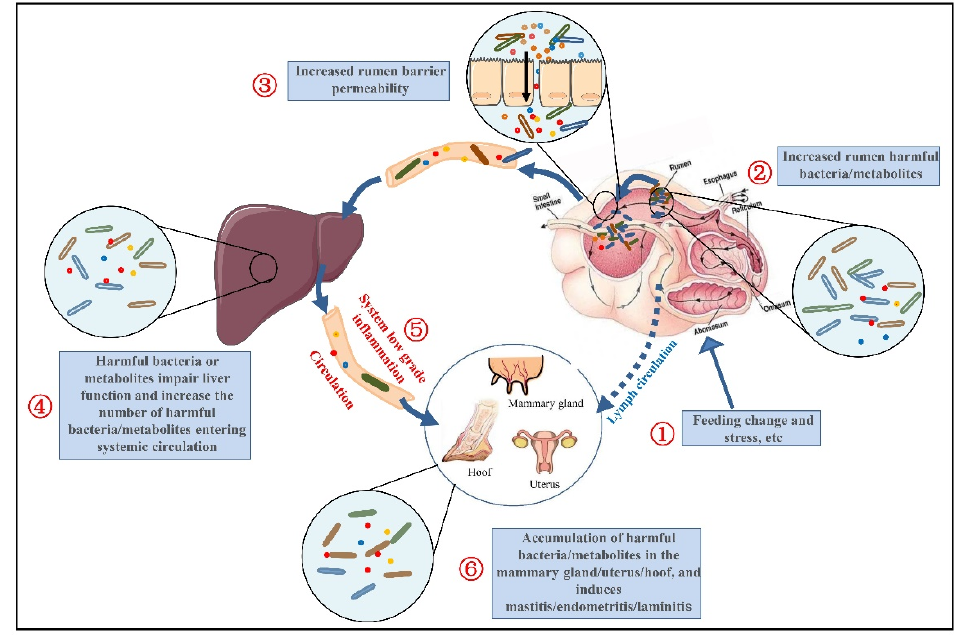
Figure 3. Mechanism by which SARA increases infectious and metabolic diseases in dairy cows.